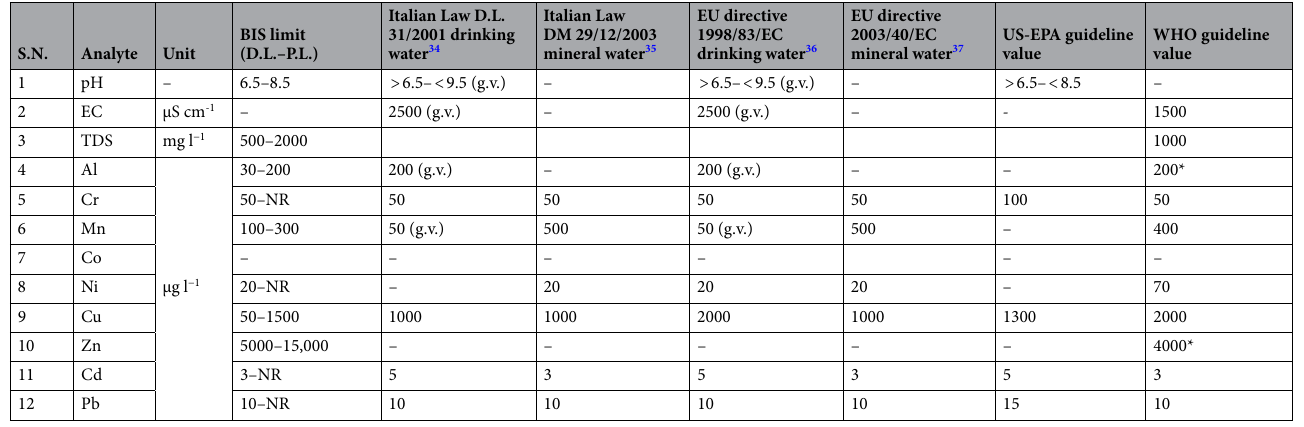
Table 1. Guideline Values of different analytes in drinking water recommended by various international regulatory agencies. D.L . desirable limit, P.L. permissible limit, N.R. no relaxation, g.v. guideline value. * Legal limit for water intended for infant consumption.